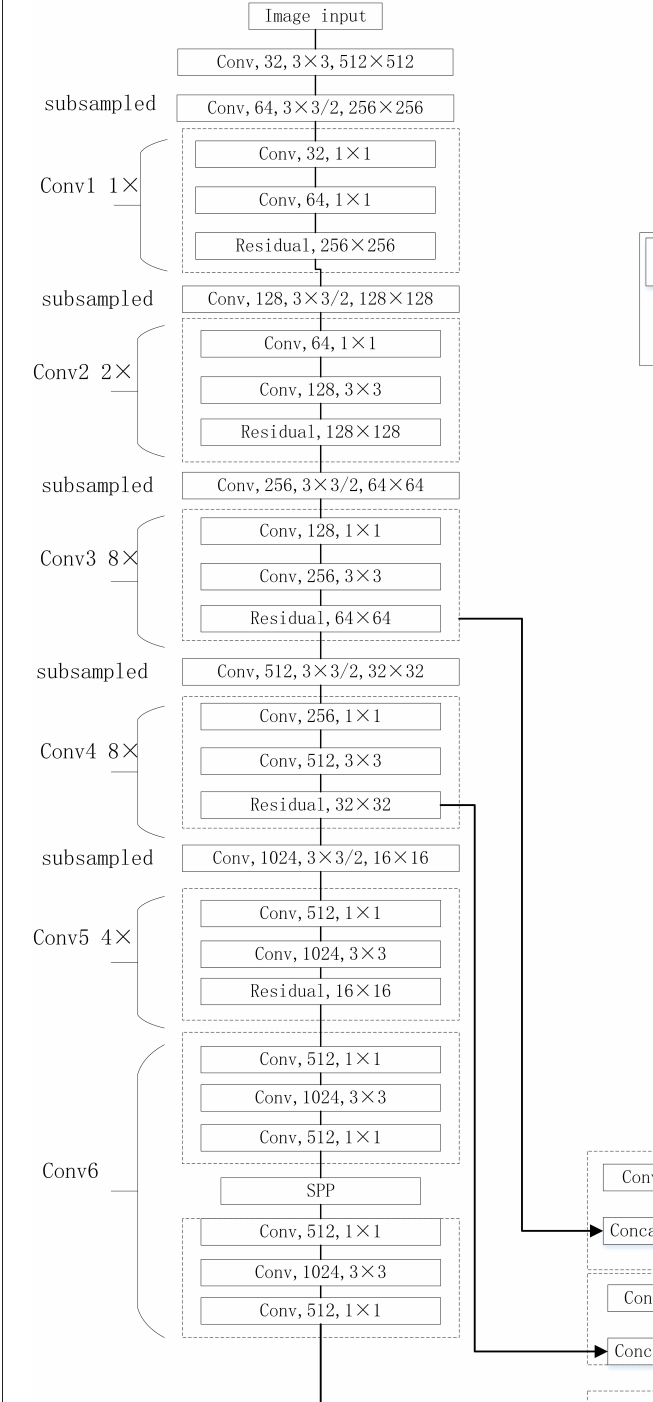
Frontiers in Plant Science |